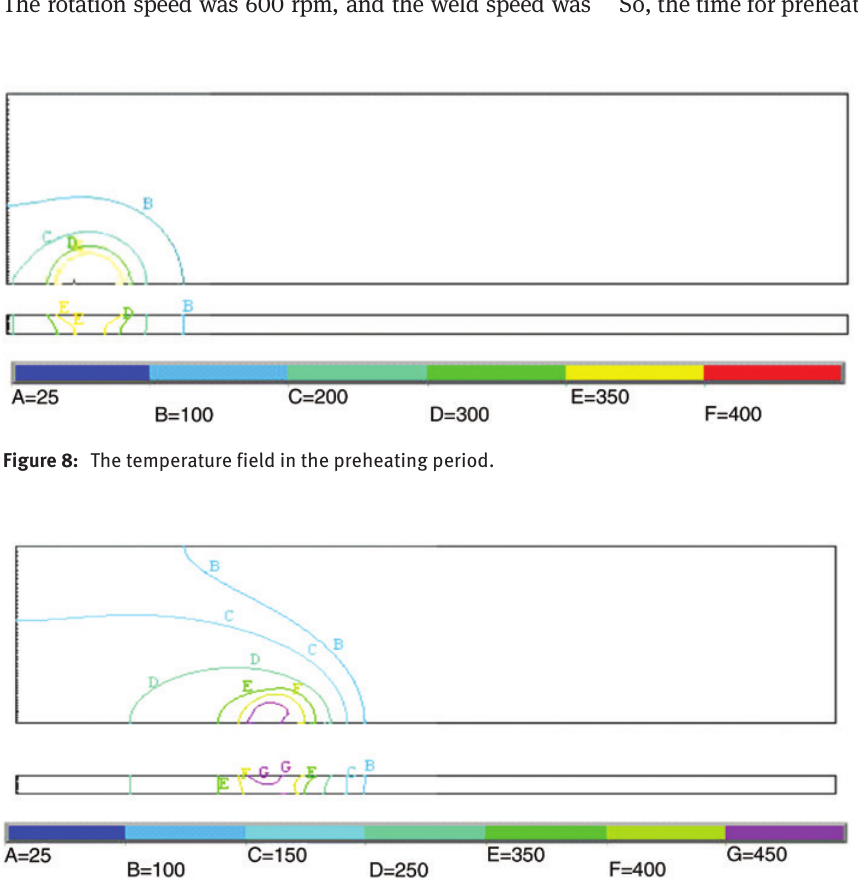
Figure 9: The temperature field in the weld